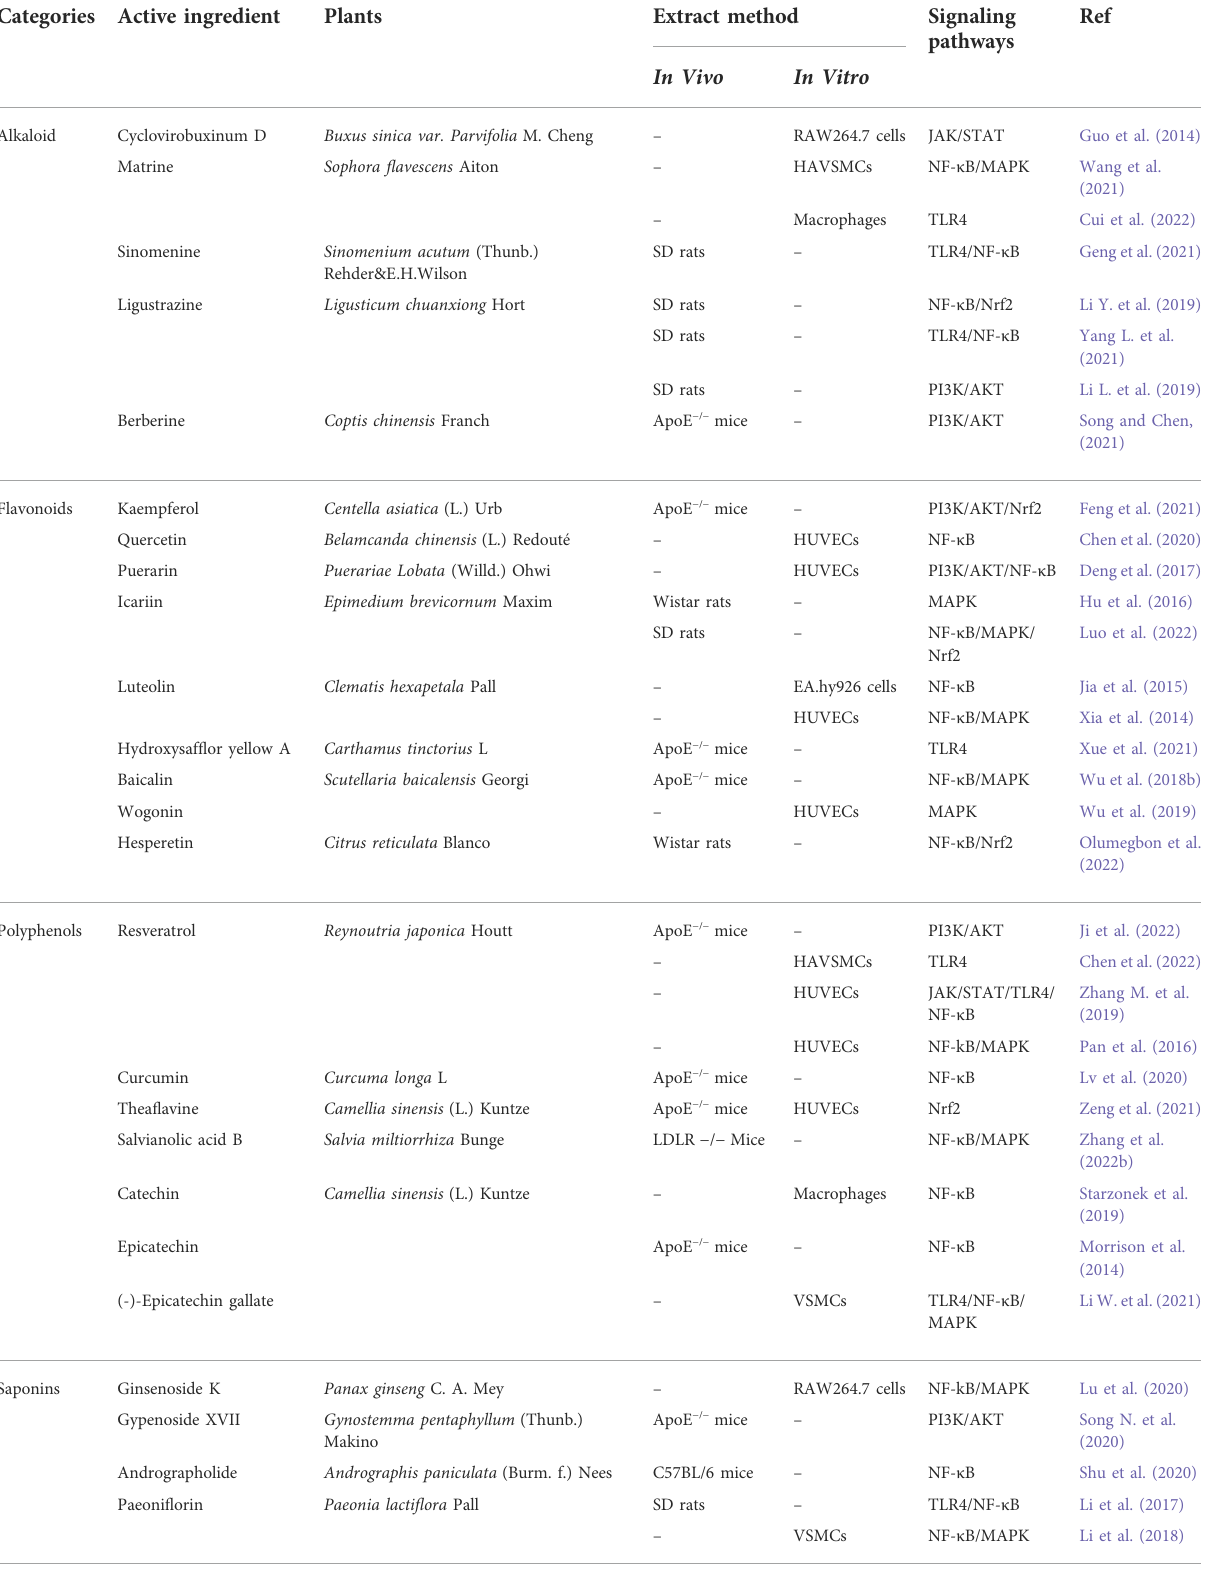
TABLE 1 Regulatory effects of natural compounds of traditional Chinese medicine on AS-related signaling